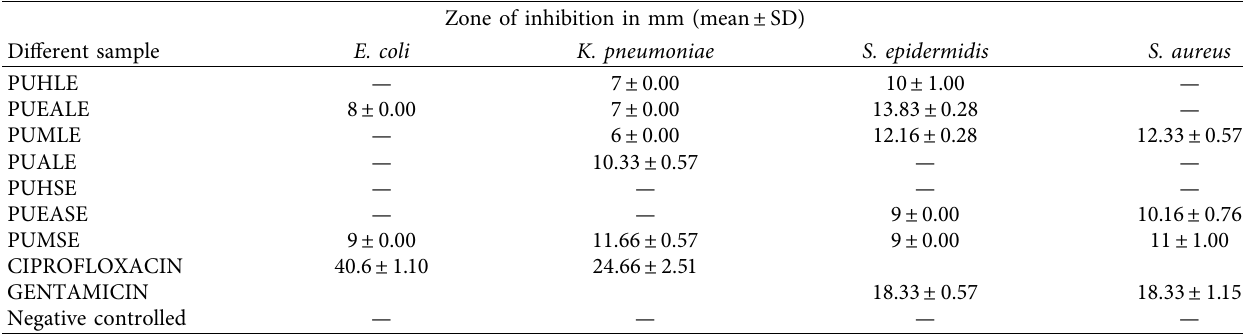
Table 6: Zone of inhibition of leaf and seed of P. utilis extract in different solvent.